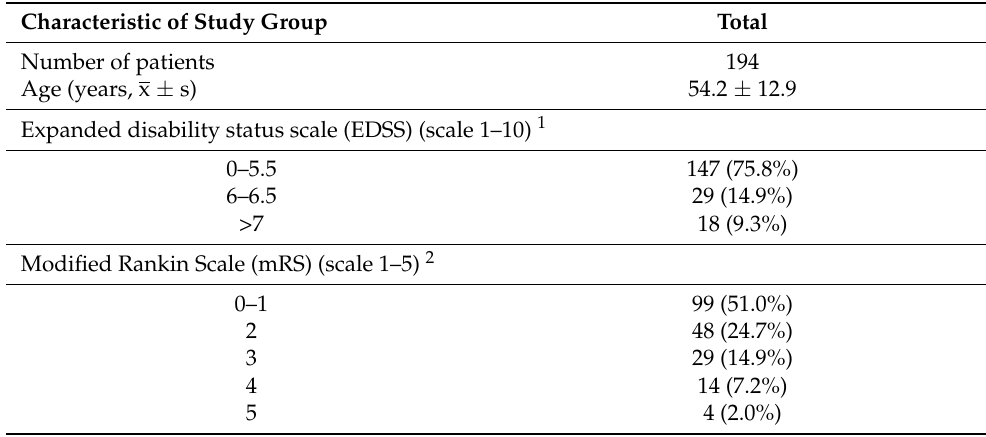
Table 1. Clinical characteristics of RRMS